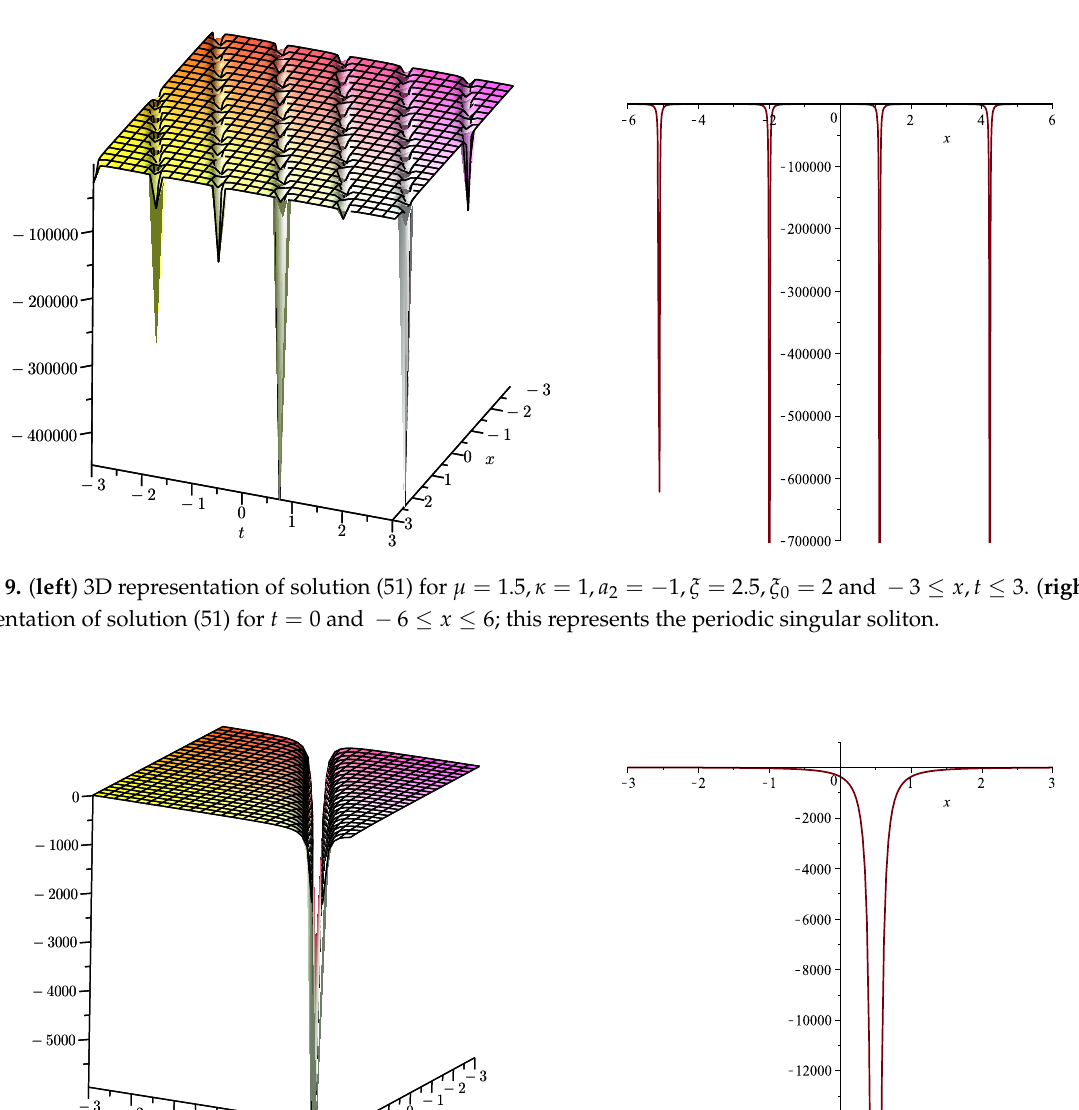
Figure 10. ( left ) 3D representation of solution (55) for µ = 0.5, κ = 2D representation of solution (55) for t = 1 and